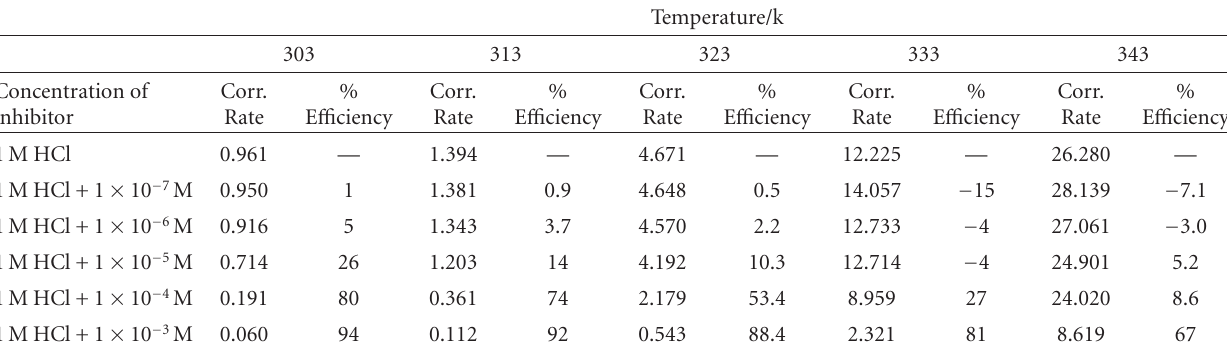
Table 1: E ff ect of concentration of trans-4-hydroxy-4 (cid:2) -stilbazole on the corrosion rate (mg · cm − 2 · h − 1 ) and percentage e ffi ciency of mild steel in 1 M HCl at various temperatures. Temperature/k 303 Concentration of